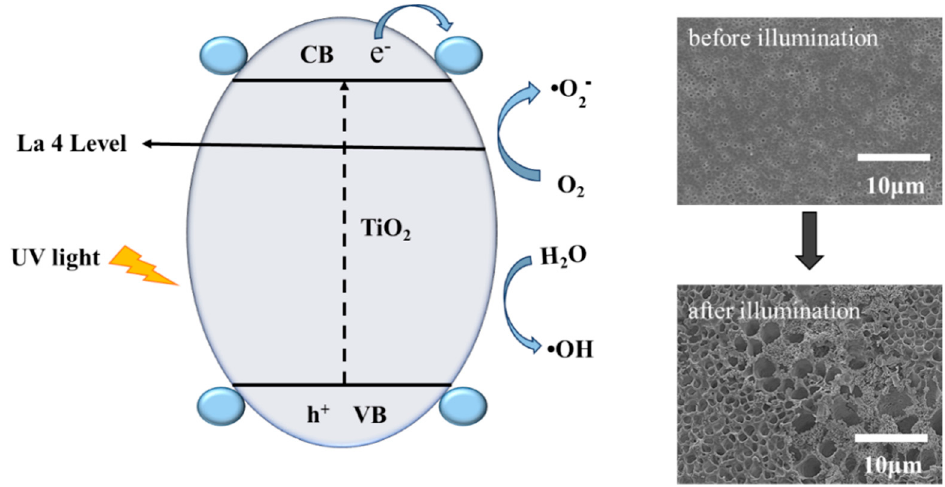
Figure 10. Photocatalytic degradation mechanism of La 3+ /TiO 2 /PVC.